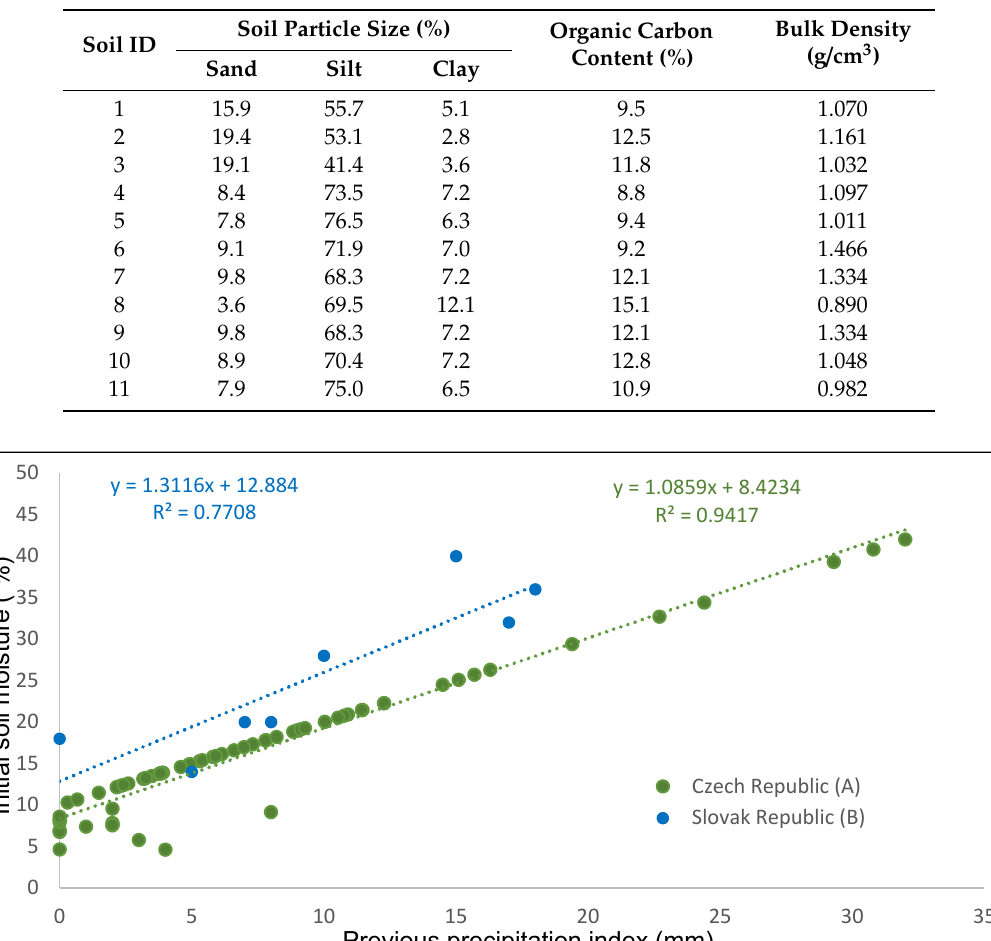
Table 4. Characteristics (minimum, maximum and mean value (x(cid:3364) )) of the selected 95 rainfall events